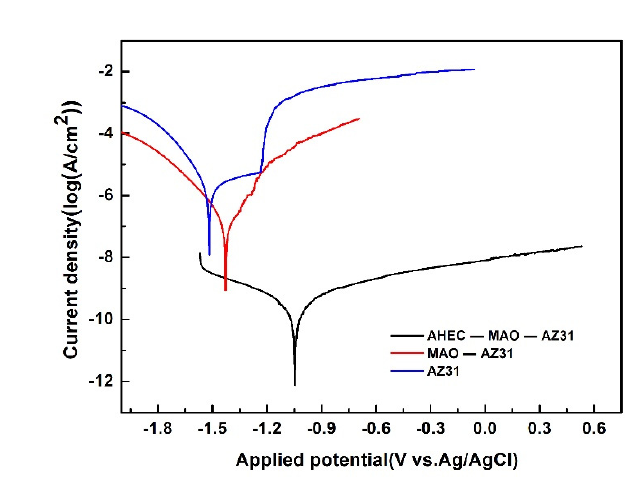
Figure 6. Potentiodynamic polarization curves for AZ31, MAO + AZ31, and AHEC + MAO + AZ31 in simulated body fluid (SBF) at room temperature. Table 3. Relative electrochemical parameters (mean ± standard